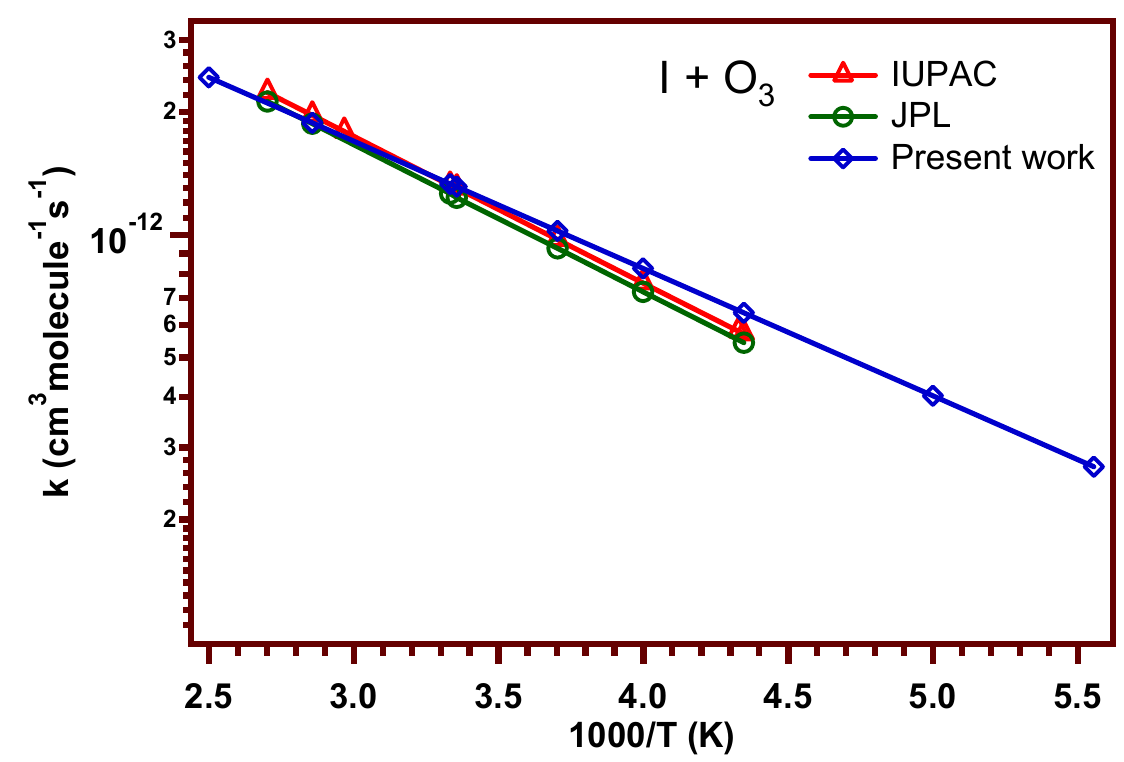
Figure 6. Arrhenius plot for the reaction of O 3 with I obtained at the MRCI + Q/aug-ano-RCC-VTZP//MP2/aug-cc-pV(T + d)Z levels of theory using CVT/SCT rate coefficients in the temperature range of 180 and 400 K along with the recommended rate coefficients by NASA/JPL [13] and IUPAC [51]. Table 9. Rate coefficients (cm 3 molecule − 1 s − 1 ) for the reaction of O 3 with I at the MRCI + Q/aug-ano-